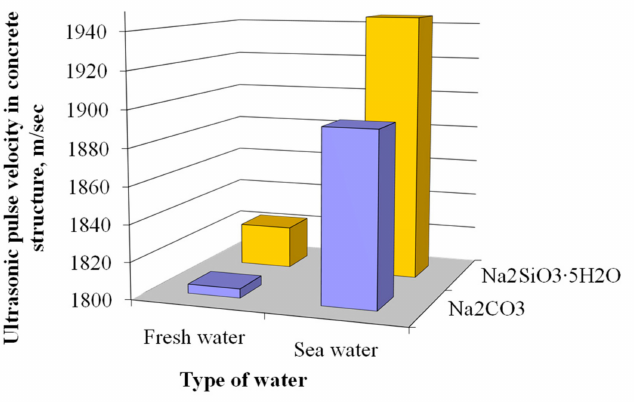
Figure 13. Ultrasonic pulse velocity in the plasticized concrete based on blast furnace